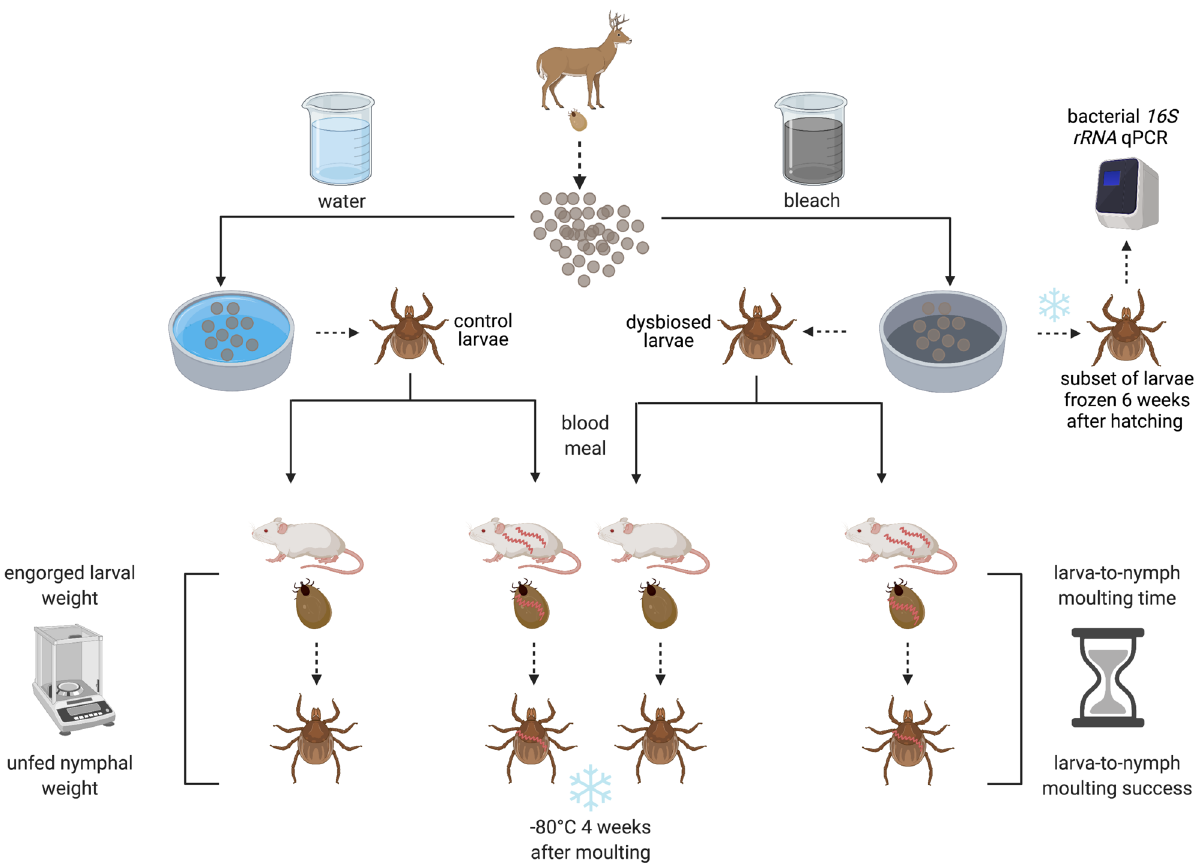
Figure 1. Experimental design of the study. Engorged adult female I. ricinus ticks (n = 10) were collected from roe deer captured near Chizé, France and laid their eggs in the laboratory. Each of the 10 egg clutches was split into two batches; one batch of eggs was surface-sterilized (washed with 10% bleach and 70% ethanol) and hatched into dysbiosed larvae, the other batch of eggs received a control treatment (washed with distilled water) and hatched into control larvae. To determine whether egg surface sterilization influenced the larval microbiota, subsets of dysbiosed larvae and control larvae were frozen at 6 weeks after hatching; these larvae were tested for the abundance of their bacterial microbiota using 16S rRNA qPCR. Larvae for each of the 20 batches (10 tick families × 2 egg surface treatments) were split into two groups of ~ 100 larvae (total of 40 groups) that were fed on either an uninfected control mouse (n = 20) or a B. afzelii -infected mouse (n = 20). For each of the 40 mice, up to 60 engorged larvae were placed in individual Eppendorf tubes and left to moult into unfed nymphs. The larva-to-nymph moulting success and survival of these engorged larvae (n = 1739) was monitored over a period of 74 days. For each of the 40 mice, up to 20 engorged larvae were randomly selected to be weighed as engorged larvae and again as unfed nymphs at 4 weeks after the larva-to-nymph moult. A subset of ~ 300 nymphs was frozen at – 80 °C and tested for B. afzelii infection using qPCR. This figure was created using visually estimated and not counted exactly) and to brush them onto each mouse. During the larval infestation, mice were anaesthetized with a mixture of xylazine, ketamine, and PBS (1:2:9; 5 μl per gram of mouse), as we have done previously 44–46,48,50 . The I. ricinus larvae blood fed for 3 days on the mice before dropping off. To facili- tate the collection of the engorged larvae, we removed the micro-isolator top from the mouse cage and placed the mouse cage in a larger rat cage that contained a shallow moat of water. This set-up allows the engorged larvae to climb out of the mouse cage, through the wire metal top, and fall into the water moat, where they are easily col- lected with a paint brush. We collected a maximum of 60 engorged larvae for each mouse. Each engorged larva was placed in an individual Eppendorf tube and was left to moult into a nymph. The Eppendorf tubes contained a piece of moistened paper towel to ensure high relative humidity and were organized in cryoboxes that were stored in the phytotron. Four weeks after the larva-to-nymph moult, 7 to 8 nymphs were randomly selected for each mouse and were frozen at – 80 °C. In summary, we froze ~ 300 nymphs (10 families × 2 egg surface treat- ments × 2 mouse infection statuses × (7–8) nymphs/mouse) for future molecular analyses of B. afzelii infection. Life history traits of immature I. ricinus ticks. One of the 40 mice died during the larval infestation. We collected a total of 1739 engorged I. ricinus larvae from the remaining 39 mice (mean = 44.6; range = 5 to 60; units are engorged larvae per mouse). These 1739 engorged larvae belonged to 4 different groups: (i) control larvae that fed on uninfected mice (n = 419 larvae), (ii) control larvae that fed on B. afzelii -infected mice (n = 429 larvae), (iii) dysbiosed larvae that fed on uninfected mice (n = 449 larvae), and (iv) dysbiosed larvae that fed on